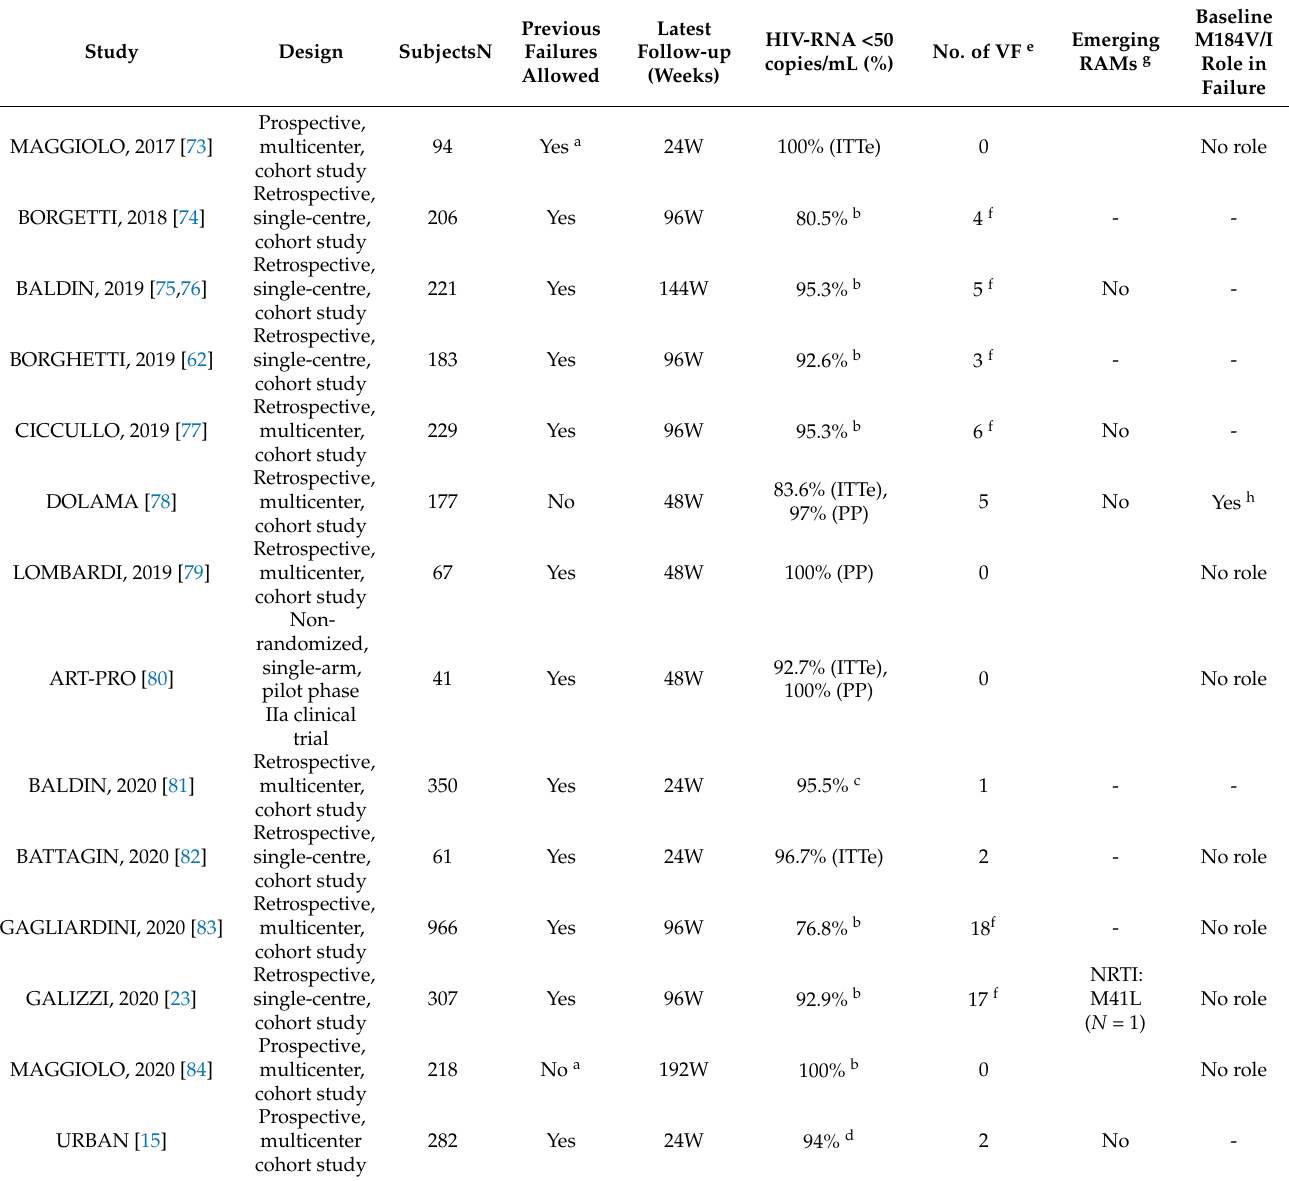
Table 5. Real-life experiences of switch to dolutegravir/lamivudine two-drug regimens in virologically suppressed HIV-1